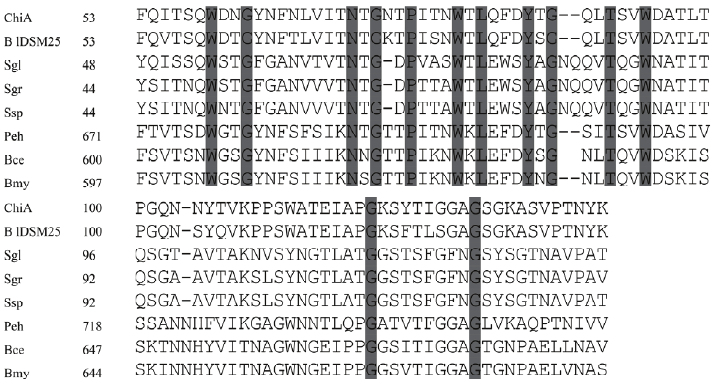
Figure 3. Alignment of CBM in ChiA with the CBMs of the chitinase from B. laterosporus DSM25 (BlDSM25, WP_003336146.1), P. ehimensis (Peh, BAC76694.1), B. cereus (Bce, EEK85987.1), B. mycoides (Bmy, EEM01294.1), and the cellulose binding domain of